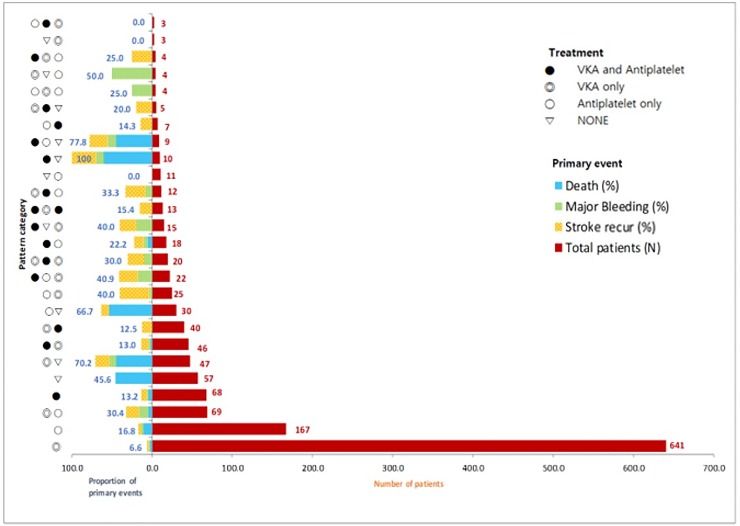
Number of patients according to treatment patterns and proportions who experienced primary outcome events according to the types (The definitions of treatment patterns are provided in Table 4.).M indicate month(s); VKA vitamin K antagonists. *Note. If there is one symbol in the pattern category, this means that only one treatment is maintained. If there are two or more symbols in the pattern category, this category indicates that the treatment was changed.